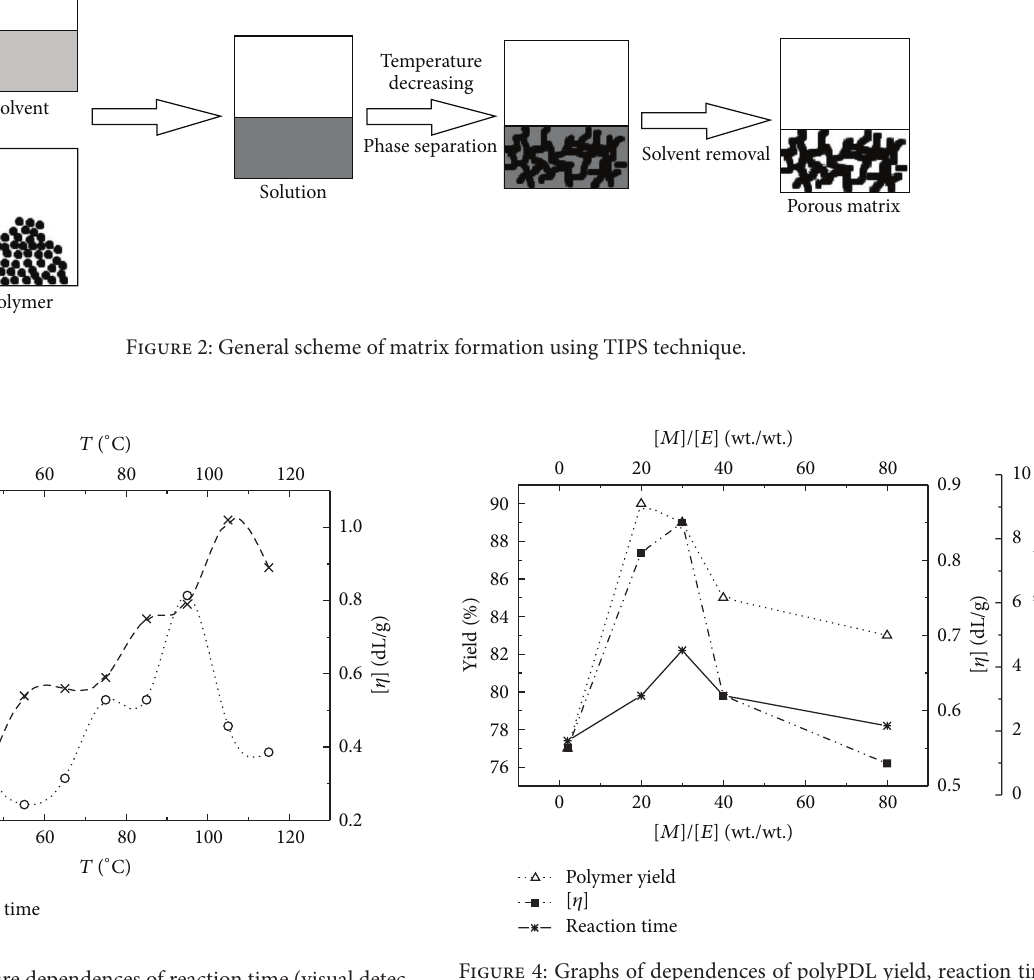
Figure 3: Temperature dependences of reaction time (visual detec- tion of reaction mixture solidification) and polymer intrinsic viscos- ity. Reaction conditions: [M]/[E] = 10/1wt./wt., [PDL] = 50wt.%.